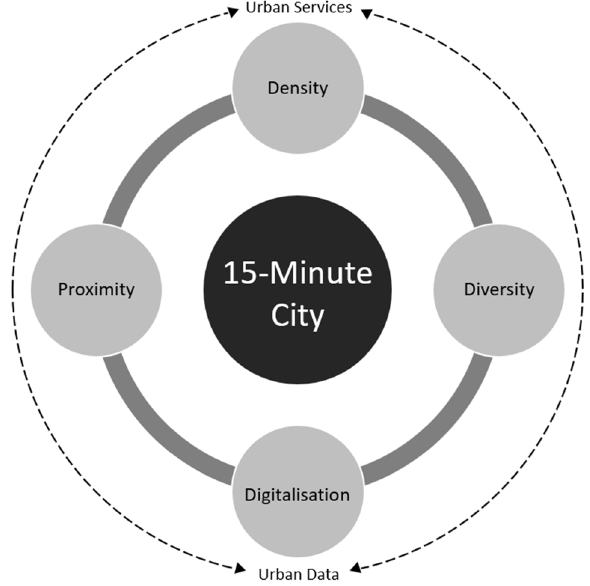
Figure 1. The 15-minute city framework as introduced by Moreno, Allam, Chabaud, Gall, and Pratlong [11].